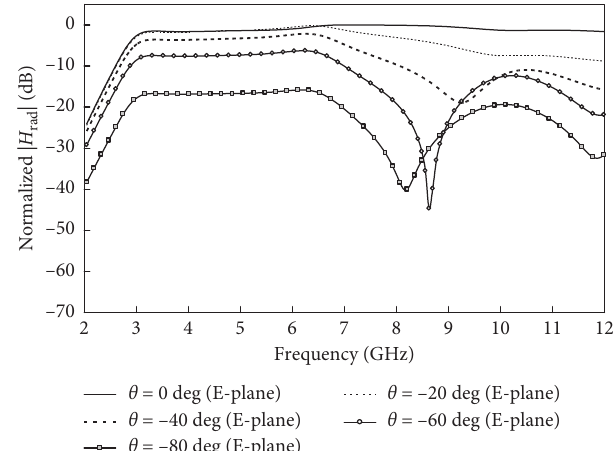
Figure 18: Simulated | H rad | of the antenna at various positions on E-plane in the downward direction.